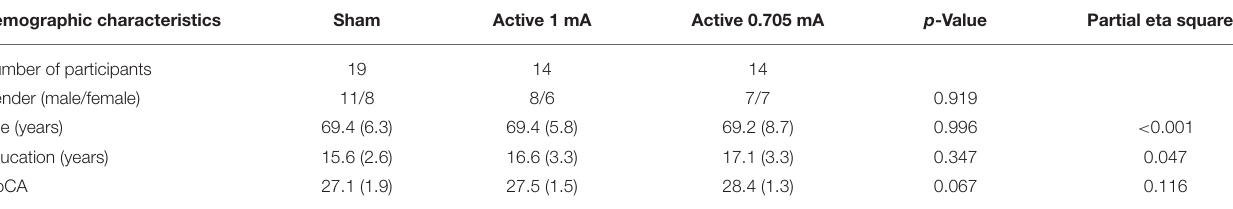
TABLE 1 | Demographic characteristics of individuals grouped according to experimental condition.